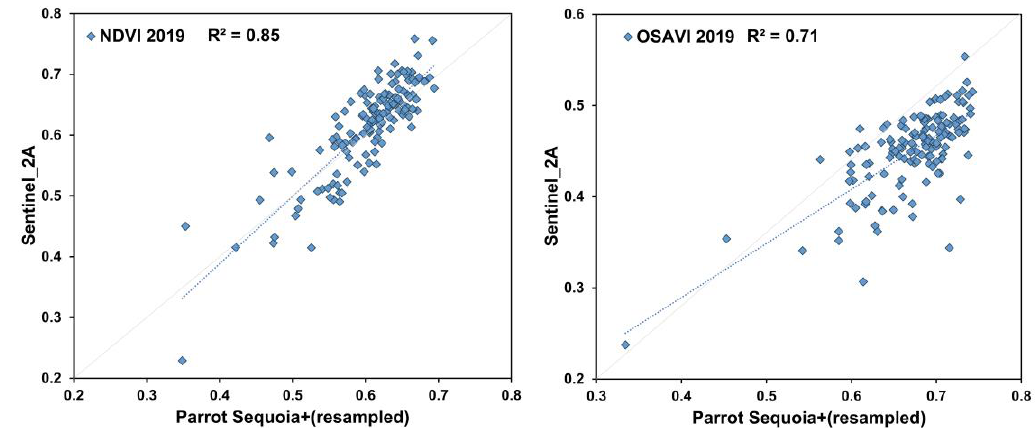
Figure 6. The left image is a comparison between NDVI derived from Sentinel_2 and Parrot Sequoia+. The right image is a comparison between OSAVI based on Sentinel_2A and Parrot Sequoia+ surveyed in May 2019.